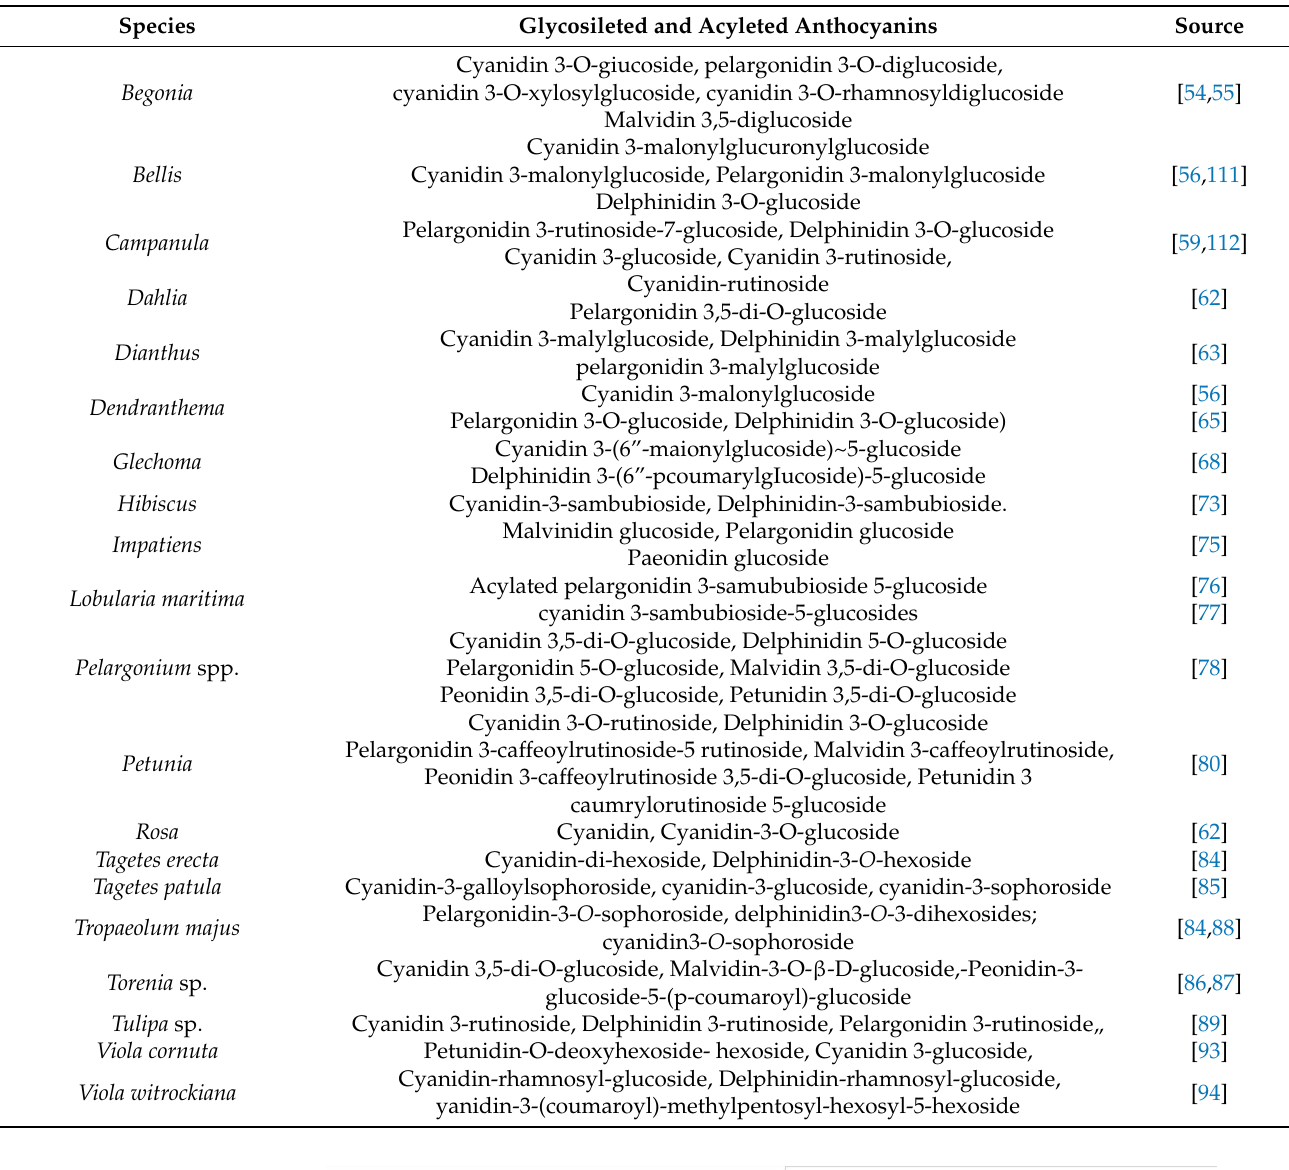
Table 2. Identified derivatives of anthocyanins listed in Table 1.